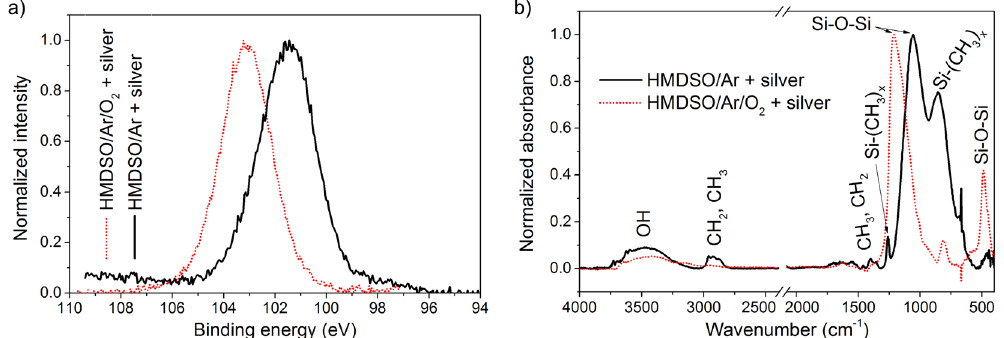
Figure 3. Chemical analysis of the NPs prepared by GAS from the Ar/HMDSO mixture with or without the addition of O 2 : ( a ) high-resolution Si 2p XPS; ( b )